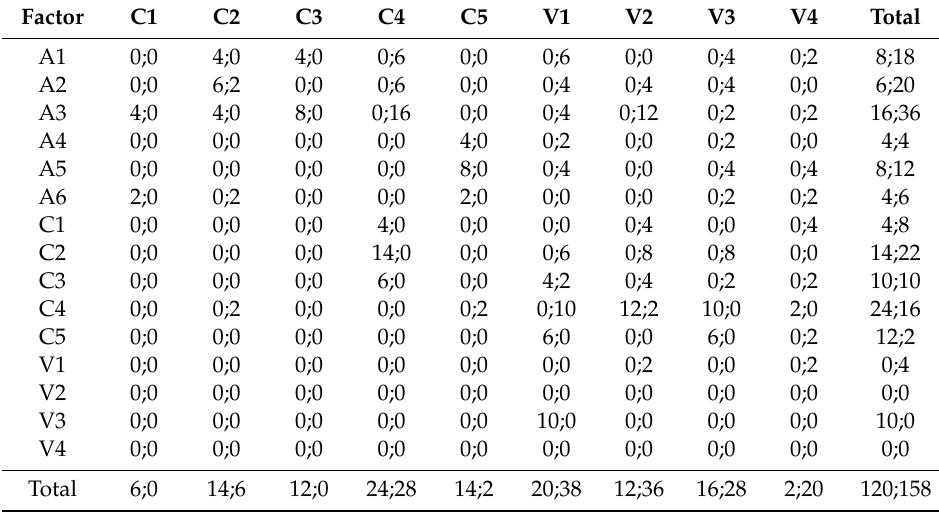
Table 6. Implication Matrix ( n =